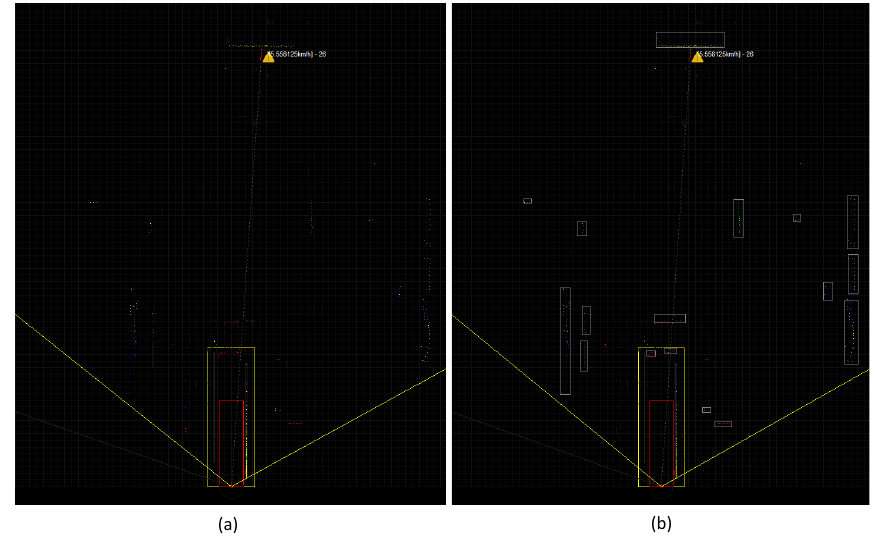
Figure 4. ( a ) Before segmentation; ( b ) after segmentation.